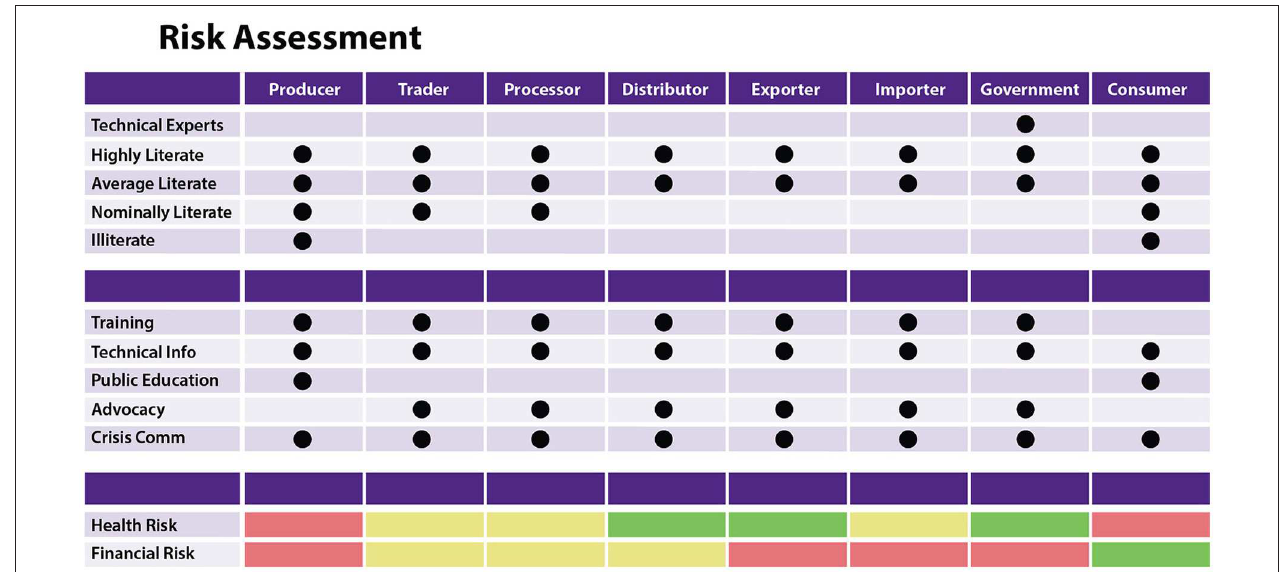
FIGURE 2 | Types of education/training on mycotoxins needed by food value chain stakeholders. The top portion of the figure subdivides different stakeholders by their general literacy and expertise in mycotoxins. Likely classes in each stakeholder group are denoted by a bullet (•). The middle portion of the figure denotes types of information and communications generally needed within a stakeholder group. The bottom portion of the figure denotes risks faced by various stakeholders based on their location in the value chain. These risks are denoted with green for low, yellow for intermediate and red for